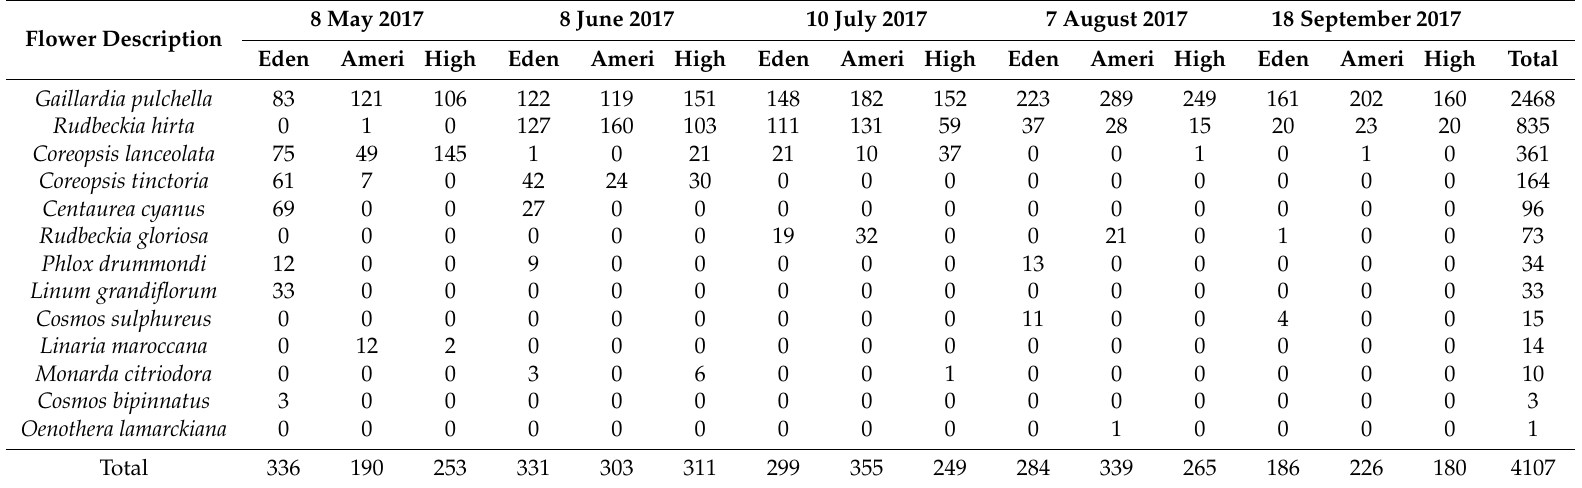
Table 1. Summary of total counts of flower species observed in subplots containing one of three southeast specific wildflower mixes: “eden”—Eden Brothers ® (Arden, NC, USA), “ameri”—American Meadows ® , (Shelburne, VT, USA), and “high”—High Country Gardens ® . Values represent total counts for each time period, and final total column represents seasonal totals observed. Flower species are ranked by total seasonal floral